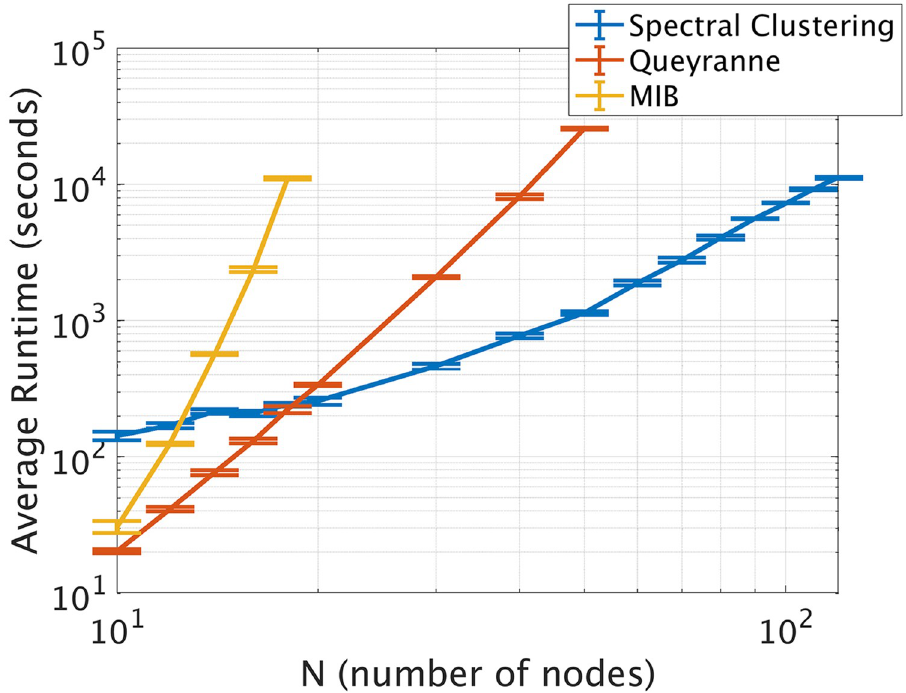
Fig 6. Average run time across for the three algorithms as a function of network size. Error bars indicate standard error of the mean across five networks of coupled oscillators of a given size. For very small brain-like networks (10-14 nodes), our spectral clustering-based approach is slower than either the Queyranne algorithm or a brute-force search for the MIB. This is because our algorithm searches through a fixed number of candidate graph cuts (see Methods). But, this feature is also the algorithm’s strength: because our algorithm searches through the same number of candidate partitions for large systems as it does for small systems, its computation time scales much less steeply than that of the other two algorithms. If our algorithm were to search through more partitions (for e.g. by iterating through more threshold values of the correlation matrices—see Methods), then it would be slower, but its run time would still scale far less steeply than the other two algorithms, because the number of candidate partitions would remain